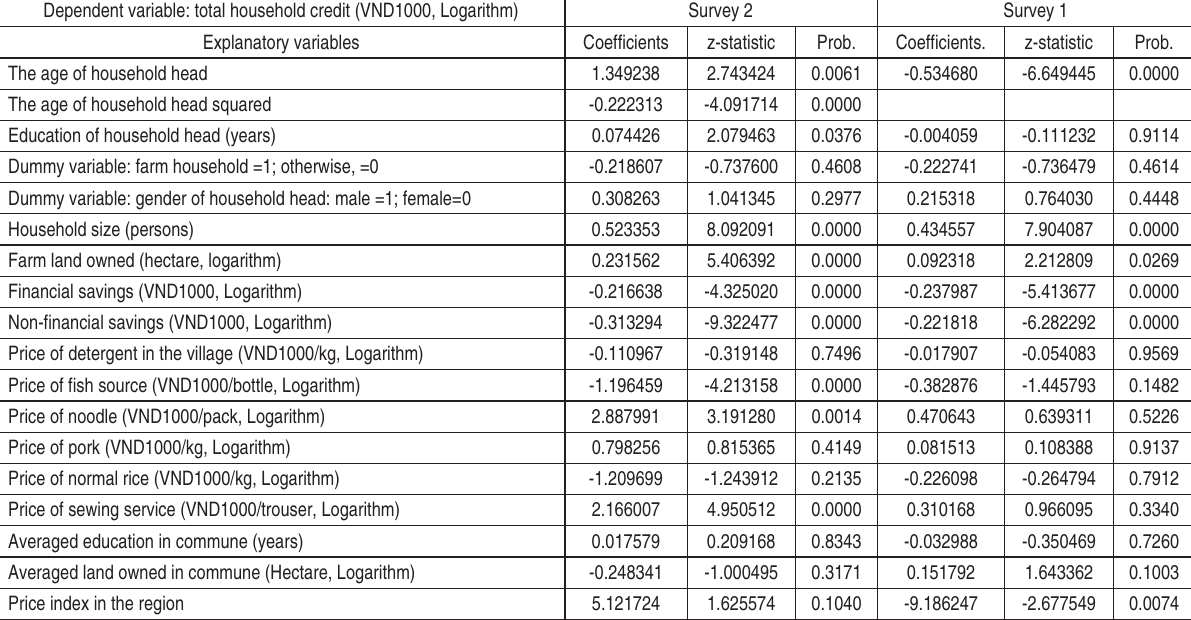
Table 1. First stage Tobit regression: determinants of household credit. The whole samples Dependent variable: total household credit (VND1000,